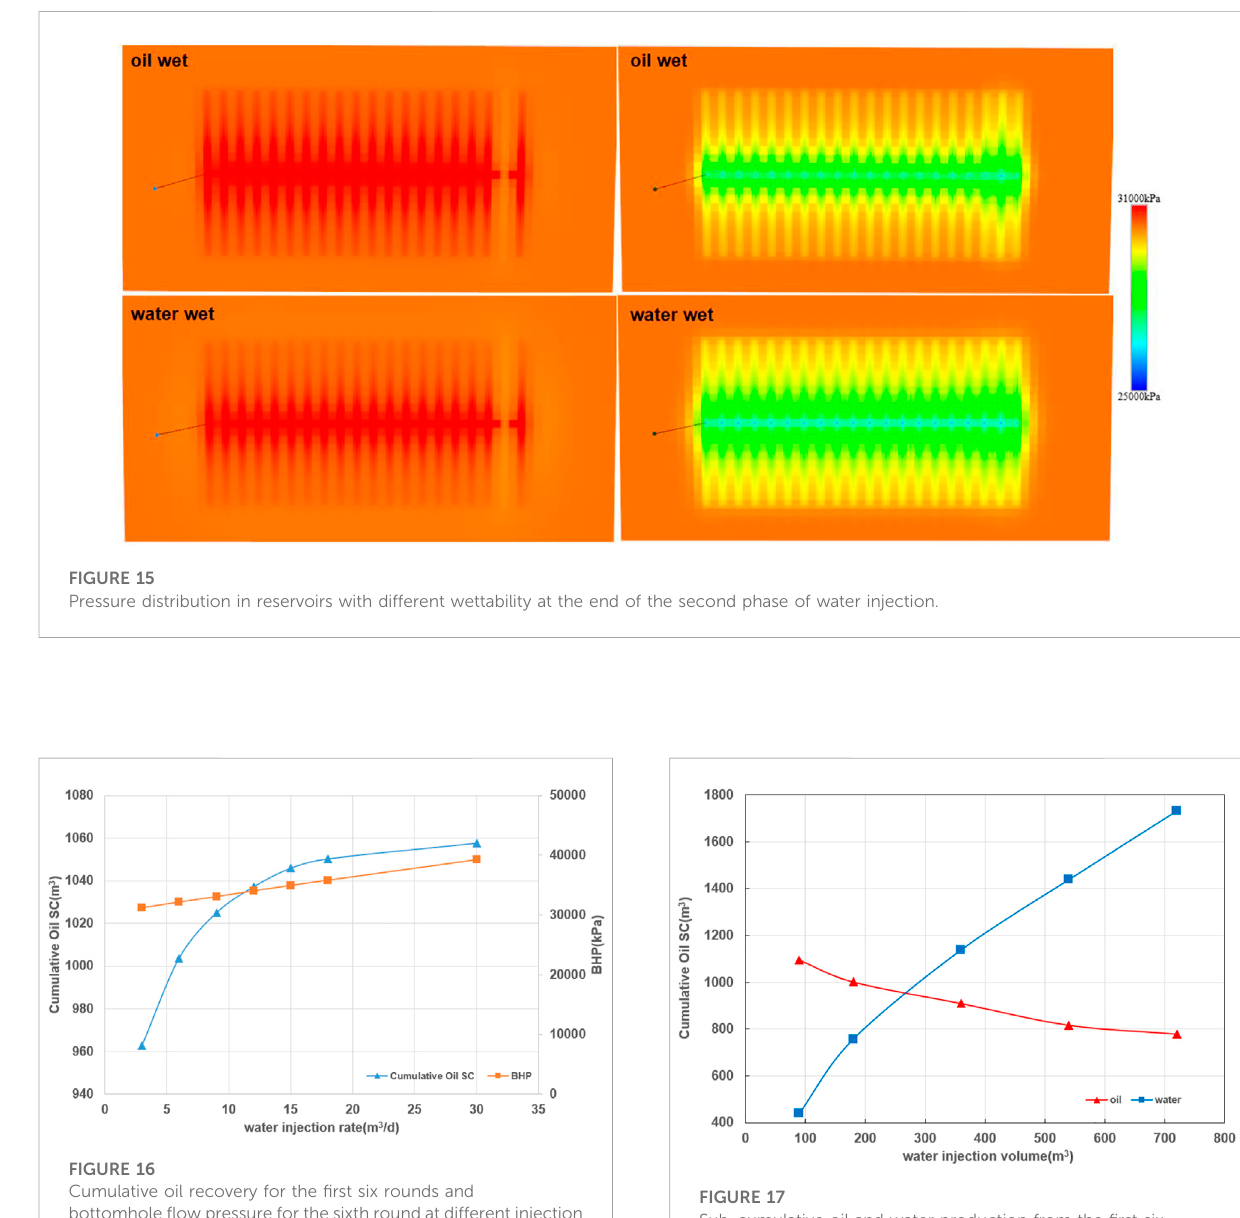
FIGURE 17 Sub-cumulative oil and water production from the fi rst six rounds (pre-development) under different water injection